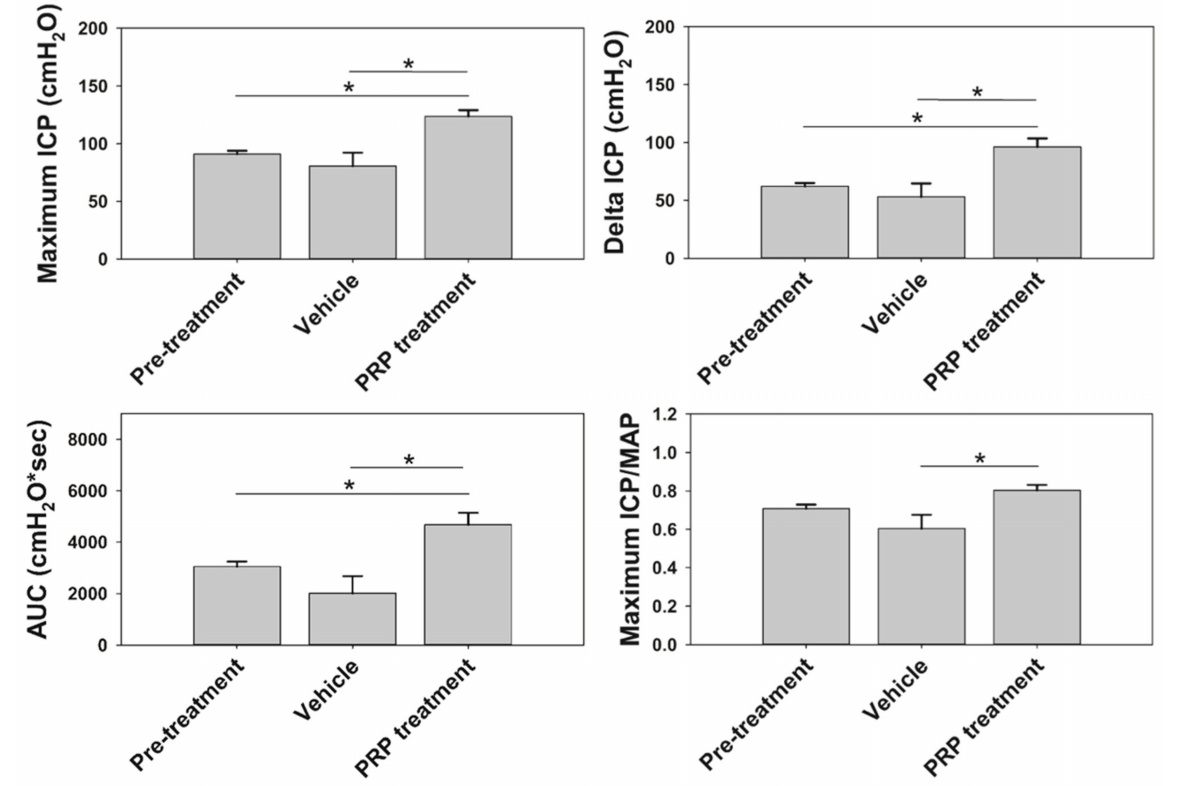
Figure 5. The illustration shows the comparison of erectile function parameters of streptozotocin (STZ)-induced diabetes mellitus (DM) rats. Pre-treatment, after 12 weeks of STZ-induced DM, 18 weeks old ( n = 8); vehicle, STZ-induced DM with erectile dysfunction (ED) and treated with saline, and ICP test performed after saline treatment for four weeks (24 weeks old) ( n = 7); platelet-rich- plasma (PRP) treatment, STZ-induced DM with ED and treated with PRP, and ICP test performed after PRP treatment for four weeks (24 weeks old) ( n = 8). * p < 0.05 when compared with PRP treatment.